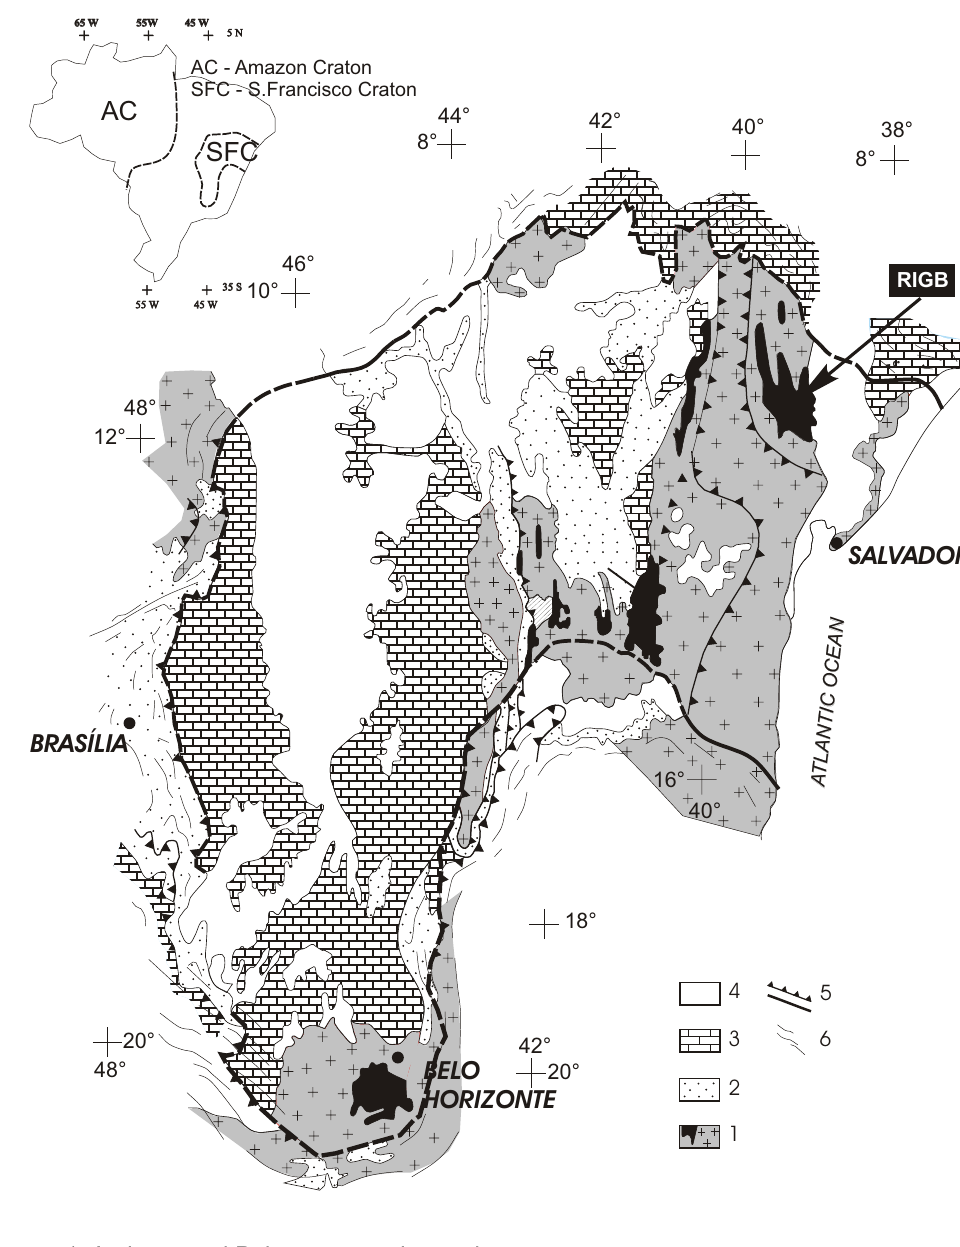
Fig. 1 – Geological sketch map of the São Francisco Craton showing the location of the Rio Itapicuru Greenstone Belt